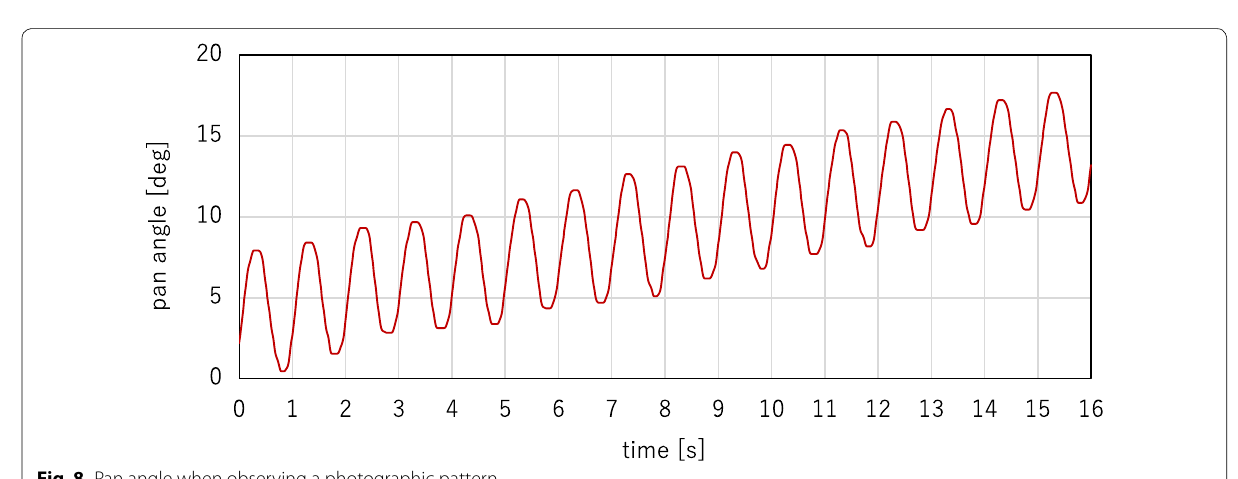
Fig. 8 Pan angle when observing a photographic